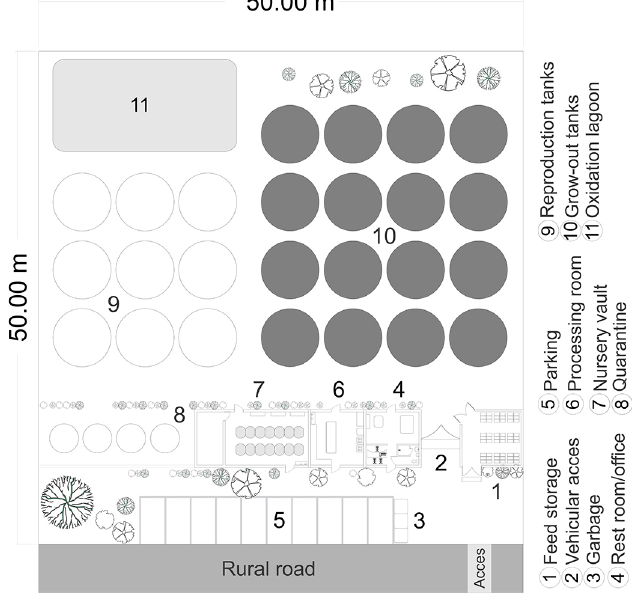
Fig. 3. General design of the proposed Small Scale Production System for Pomacea patula catemacensis with minimum space requirement of 1 ⁄ 4 Ha.